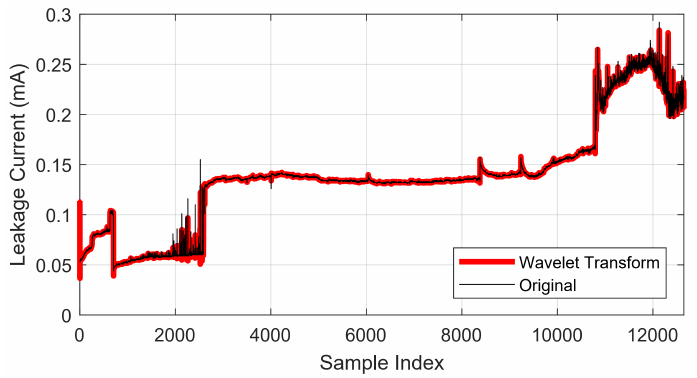
Figure 6. Wavelet transform